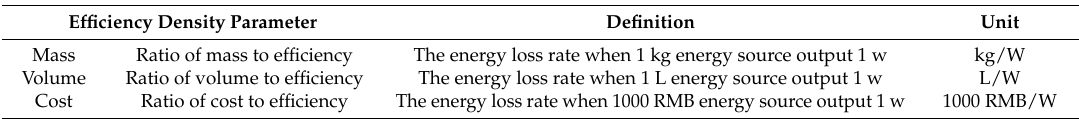
Table 4. Parameter of efficiency density.